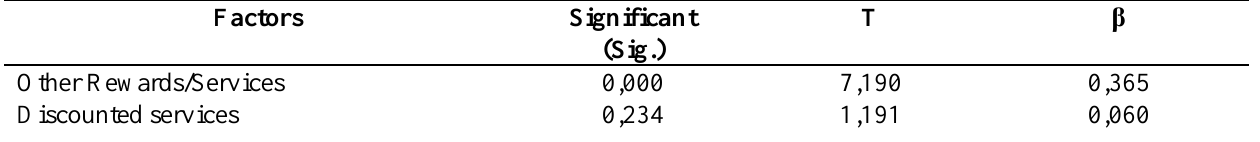
Table 9. Regression analysis of the attitude commitment variable